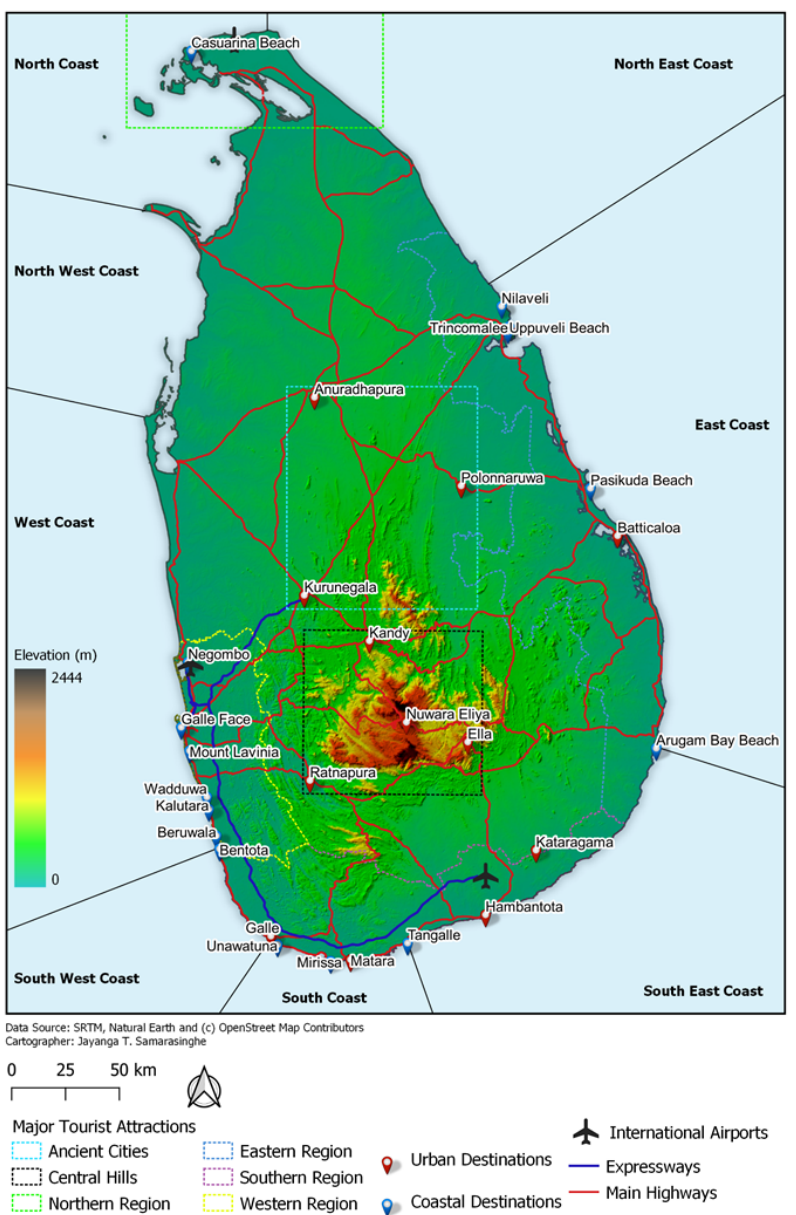
Figure 1. Study area and specific tourist